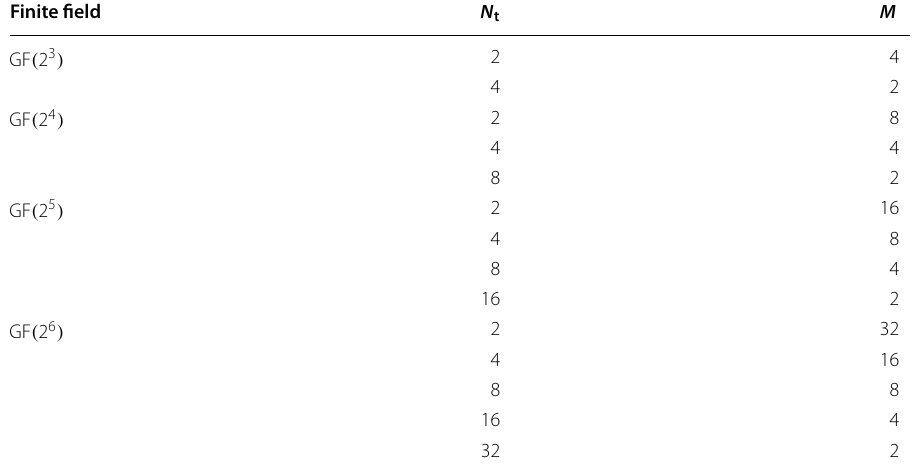
Table 2 Different communication scenarios with RS code over various Galois fields Finite